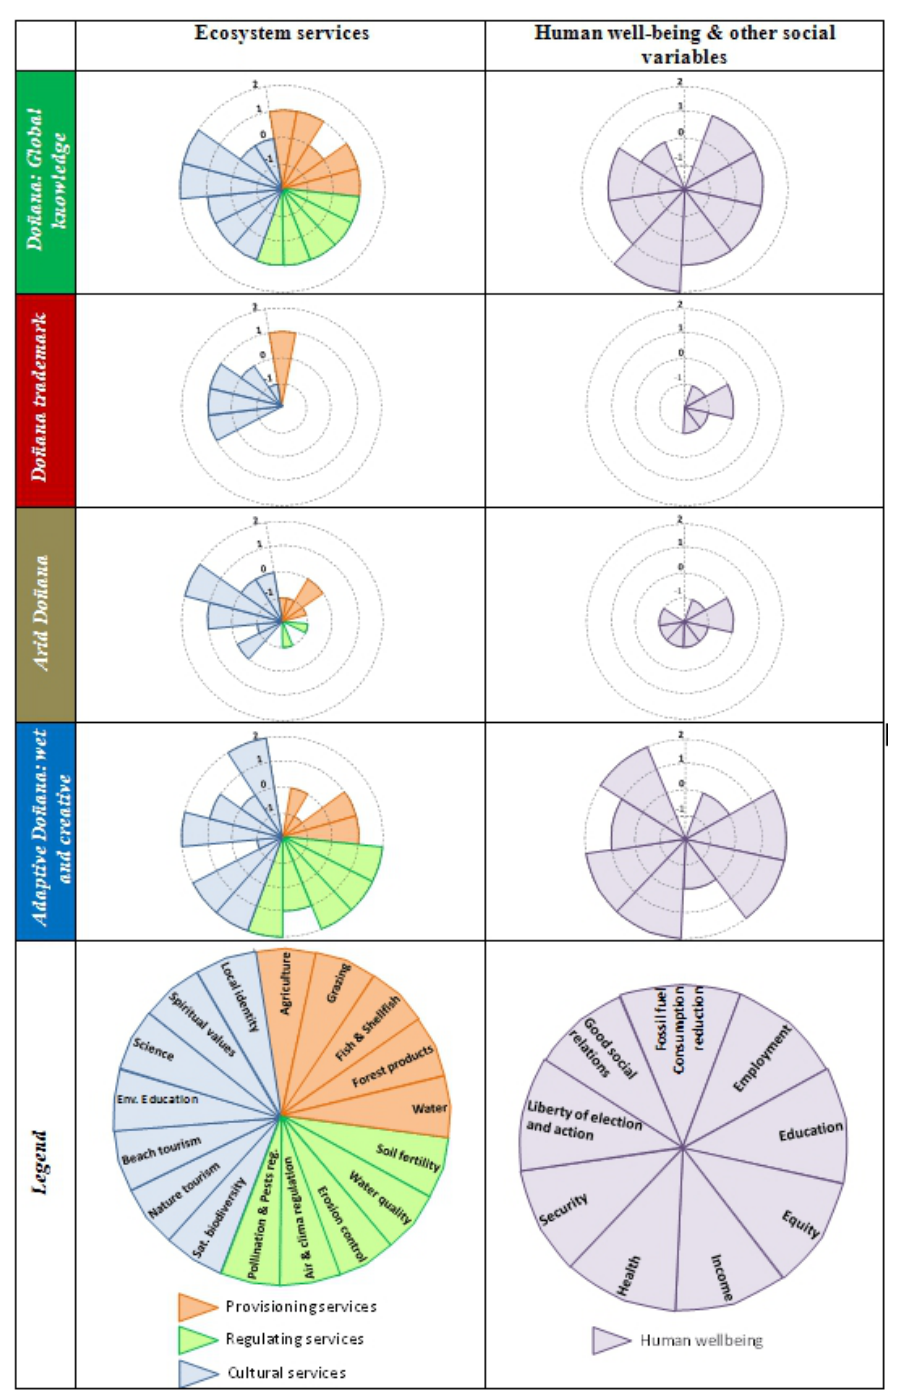
Fig. 5 . Provision of ecosystem services and human well-being variables under each scenario, compared to the current situation (big increase = 2; increase = 1; constant = 0; decrease = - 1, large decrease = - 2). Abbreviations: Pollination & pests reg. = Pollination & pests regulation; Sat. biodiversity = Satisfaction for biodiversity; Env. Education = Environmental